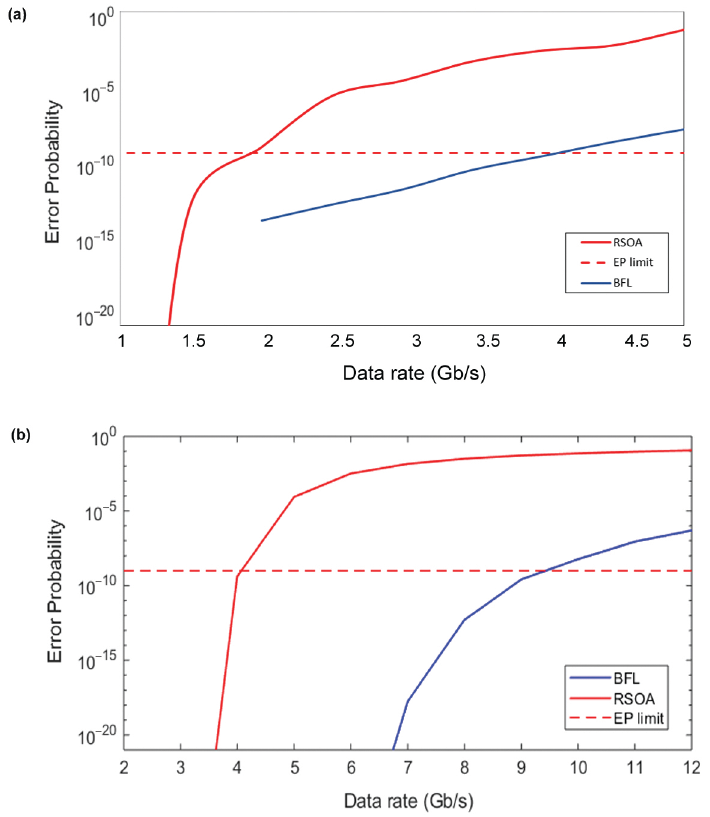
Figure 11. Error Probability ( EP ) vs. RSOA direct modulation data rate at the RSOA and BFL output: ( a ) experimental and ( b ) theoretical. EP limit is set to 10 − 9